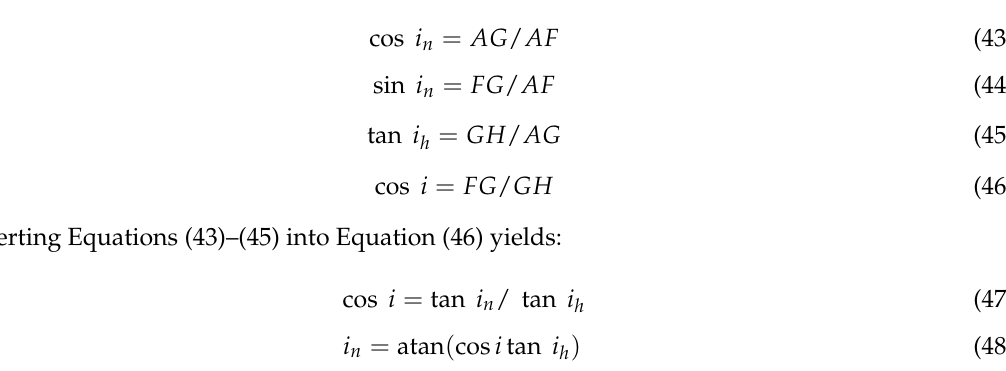
From Figure 8: the line FH is parallel to the lines AB and CD; the triangle FGH is situated in a vertical plane; and the line GH also is vertical. It then follows